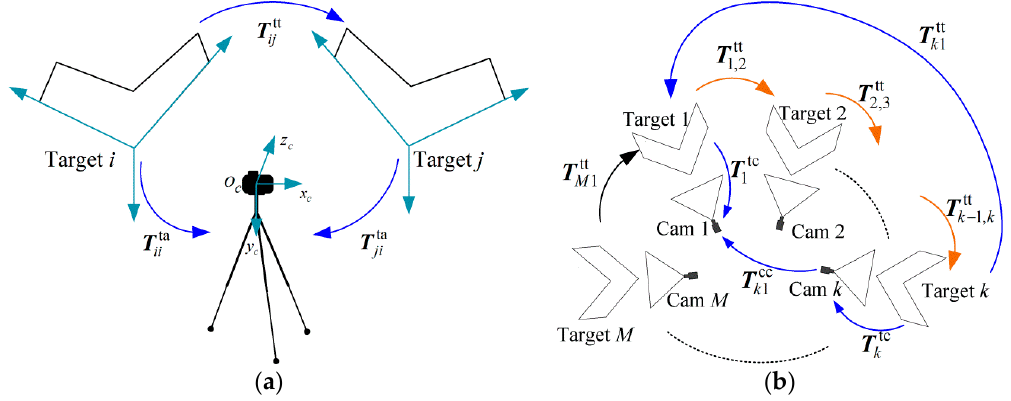
Figure 2. ( a ) Two adjacent targets ( i , j ) captured by the auxiliary camera; ( b ) The principle of the global calibration.